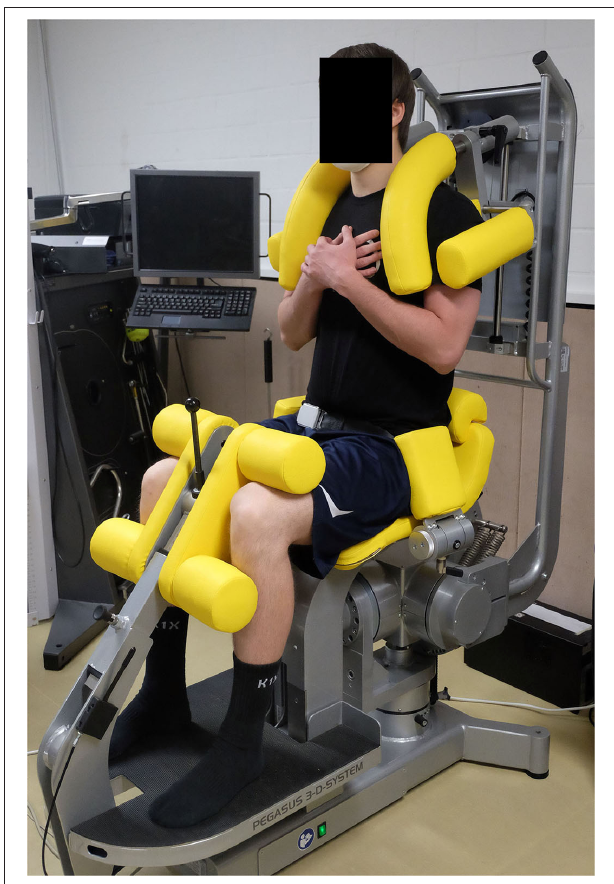
FIGURE 2 | Set-up of the Pegasus 3-D system and participant positioning for the trunk strength testing.